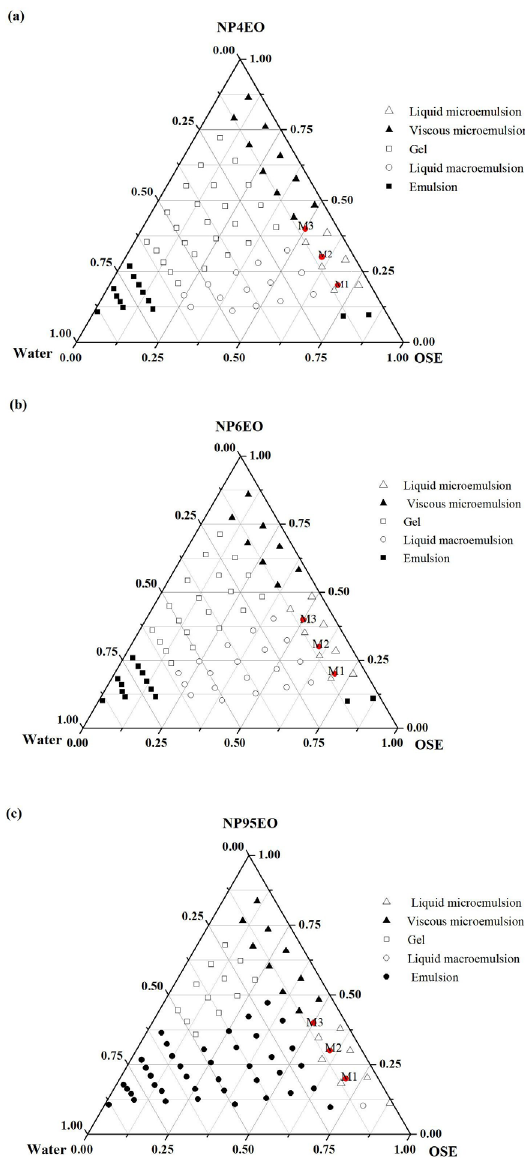
Figure 1. Ternary diagram for systems at 25 ºC: OSE, water and (a) NP4EO, (b) NP6EO and (c) NP9.5EO.